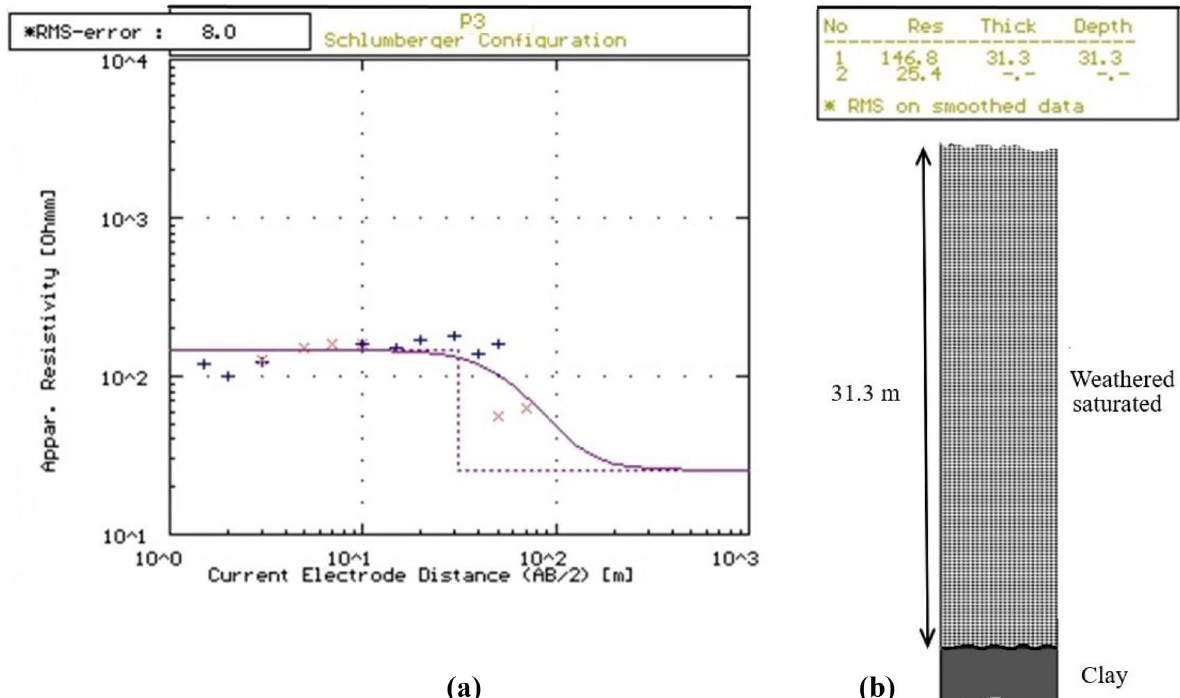
Fig. 6 a Curve matched from RESIST software for P3, b Geological profile for